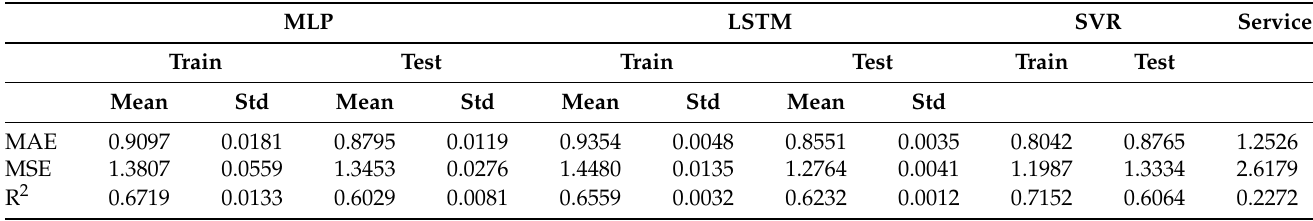
Table 12. Comparison of the effectiveness of the MLP model, two other models, and the weather service in forecasting the mean daily wind speed.